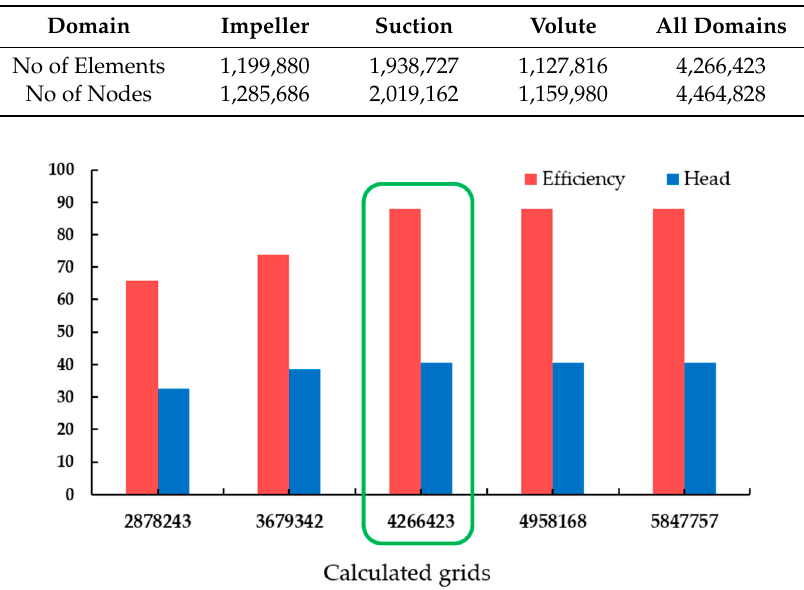
Figure 2. Mesh overview of the flow domains.